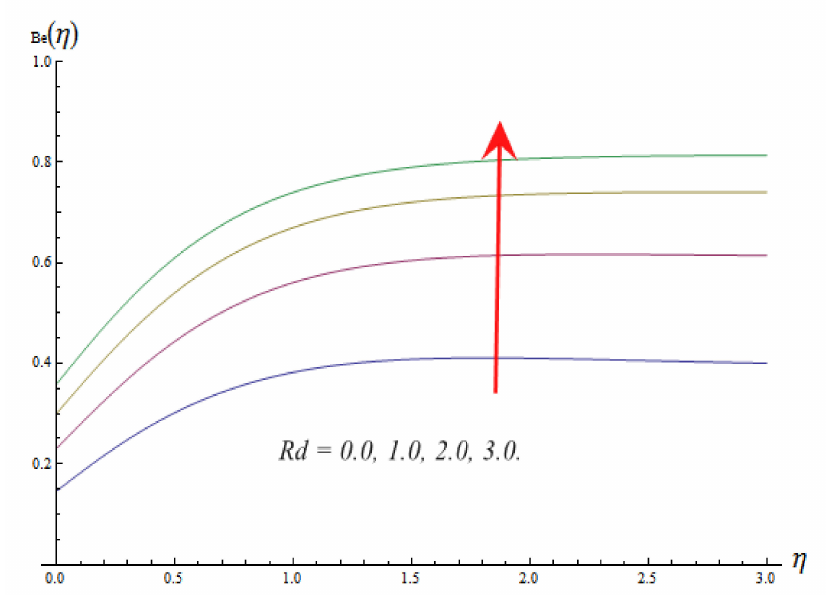
Figure 19. Impact of Rd on Be ( η ) keeping Pr = 0.5, Ha = 0.2, Γ = 0.2, λ = 2, Ec = 0.2, Br = 2, β 1 = 0.2, λ 1 = 0.2, K ∗ =